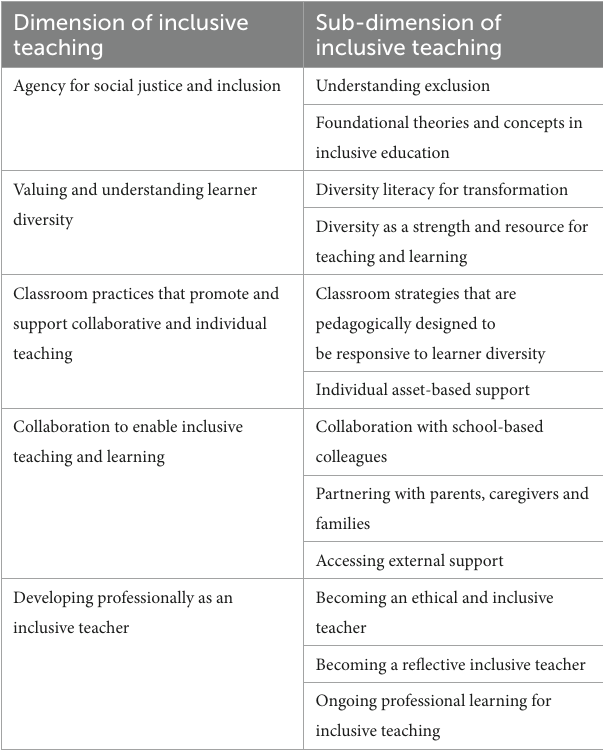
TABLE 1 Dimensions and sub-dimensions of inclusive teaching (Source: DHET,